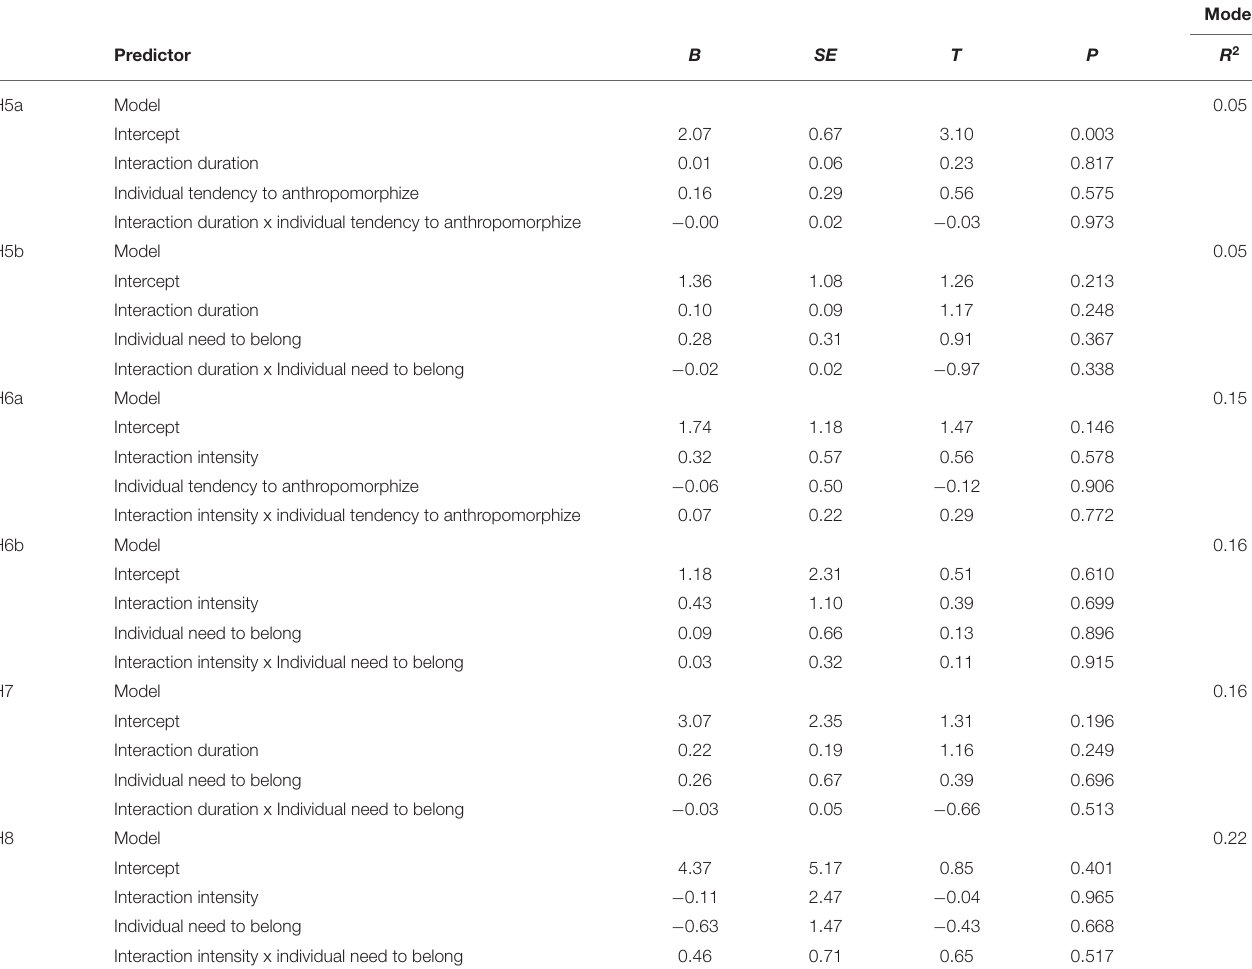
TABLE 6 | Moderated regression analyses testing the effect of interaction duration on perceived anthropomorphism moderated through individual tendency to anthropomorphize (H5a), respectively, individual need to belong (H5b); the effect of interaction intensity on perceived anthropomorphism moderated through individual tendency to anthropomorphize (H6a), respectively, individual need to belong (H6b); the effect of interaction duration on perceived social presence moderated through individual need to belong (H7); the effect of interaction intensity on perceived social presence moderated through individual need to belong